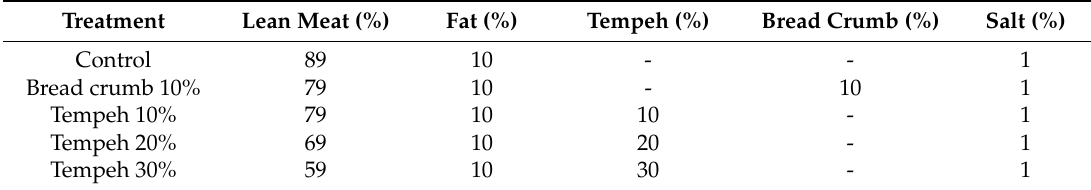
Table 1. Composition of the five patty